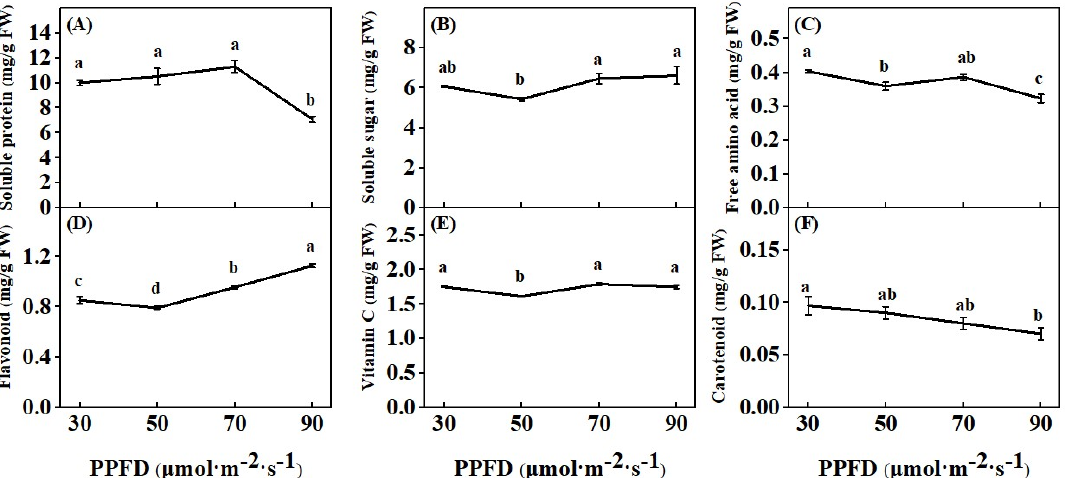
Figure 5. Effects of different light intensity on the contents of soluble protein ( A ), soluble sugar ( B ), free amino acid ( C ), flavonoid ( D ), vitamin C ( E ), and carotenoid ( F ) in broccoli microgreens. The lowercase letters in all figures represent the significant difference ( p < 0.05). Vertical bars indicate the means ± SE (n = 3).